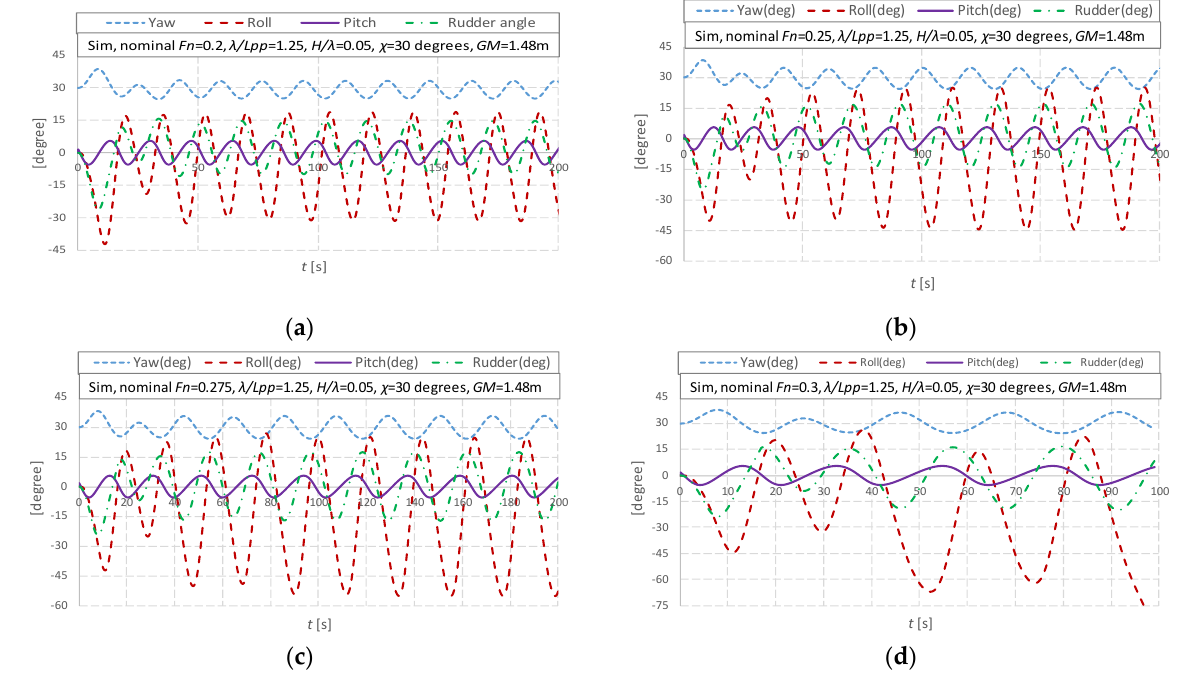
Figure 12. The time-domain rolling, pitching, yawing motions, and rudder angle using the 6 DOF numerical method, ( a ) Fn = 0.20; ( b ) Fn = 0.25;( c ) Fn = 0.275; ( d ) Fn = 0.30.